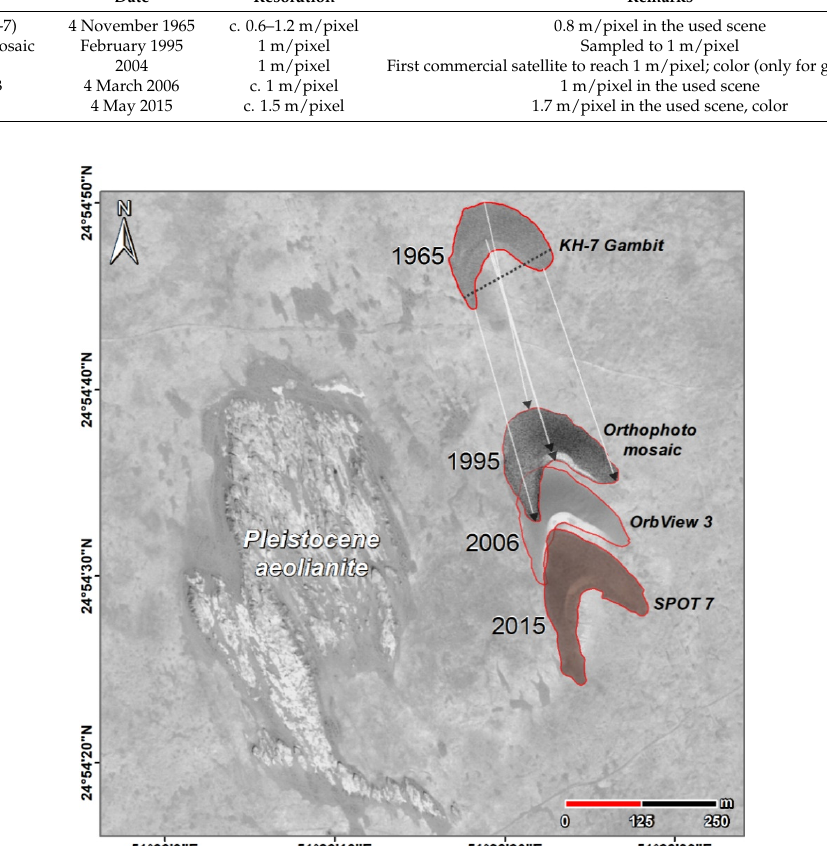
Figure 5. Approach of multitemporal satellite and aerial image analysis exemplified for barchan dune B8 (Figure 1b). Between 1965 and 2015, the entire barchan moved for ca. 587 m towards SSE (average value).